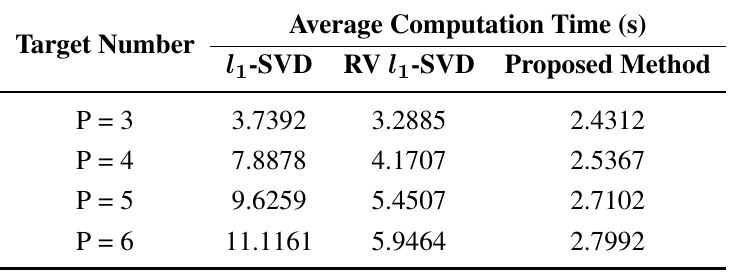
-SVD, RV l -SVD and the proposed method for 1 1